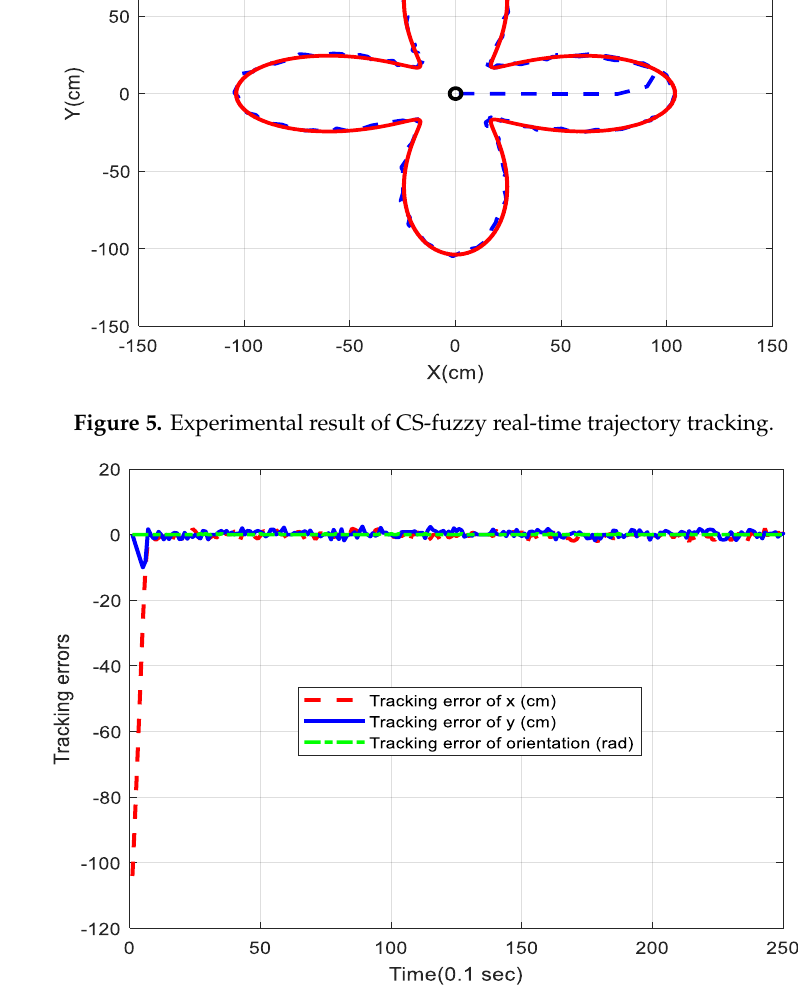
Figure 6. Experimental tracking errors of the position and orientation of the omni-Mecanum-vehicle.